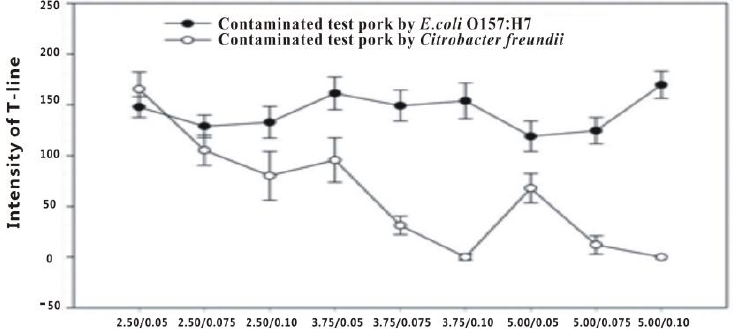
Figure 2. Signal intensities of the Au-LFIA strip test lines with pork broth samples spiked with E. coli